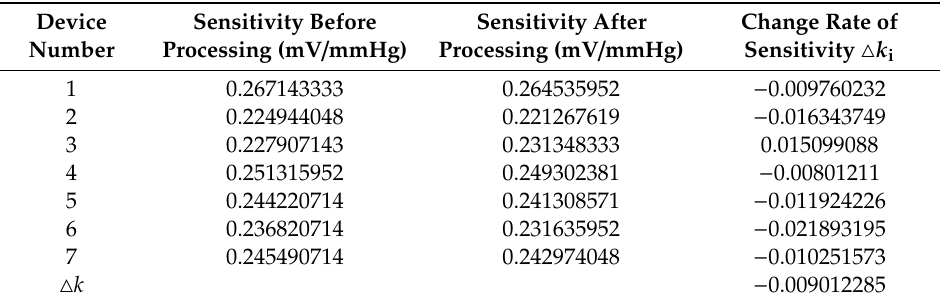
Table 2. Sensitivities of pressure sensors before and after processing treatment and their change